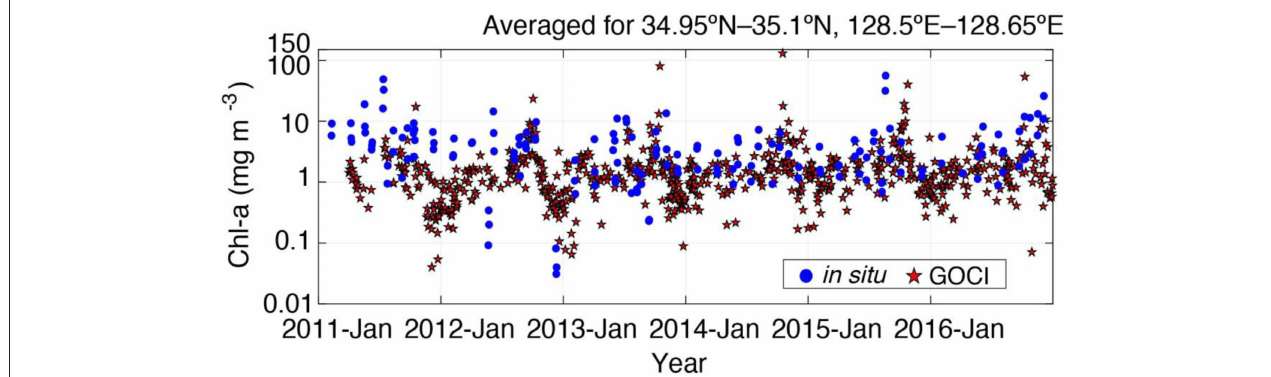
FIGURE 8 | Time series of the in situ Chl-a values (blue circles) and GOCI-derived Chl-a estimates from the YOC algorithm (red stars), averaged for the blue box area shown in Figure 1 (34.95 ◦ N − 35.1 ◦ N and 128.5 ◦ E − 128.65 ◦ E). Pixel exclusion criteria were the same as in Figure 7